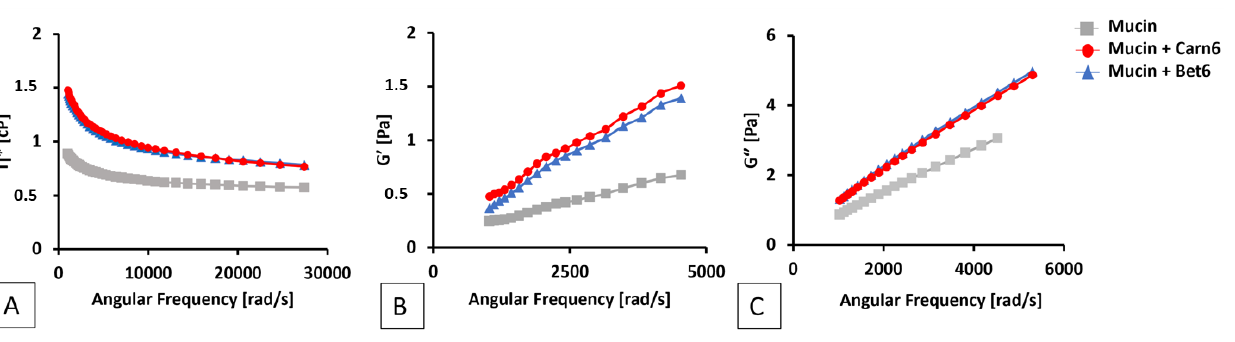
Figure 5. Rheological profiles of a mucin sample (reference) and mucin in the presence of ILs (either Bet6 or Carn6) at a concentration of 0.27 M (above CAC): ( A ) elastic modulus (G (cid:48) ); ( B ) viscous modulus (G (cid:48)(cid:48) ), ( C ) complex viscosity ( η *).